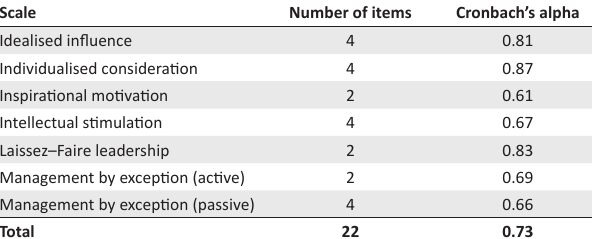
TABLE 5: Reliability statistics of the Multi-factor Leadership Questionnaire.